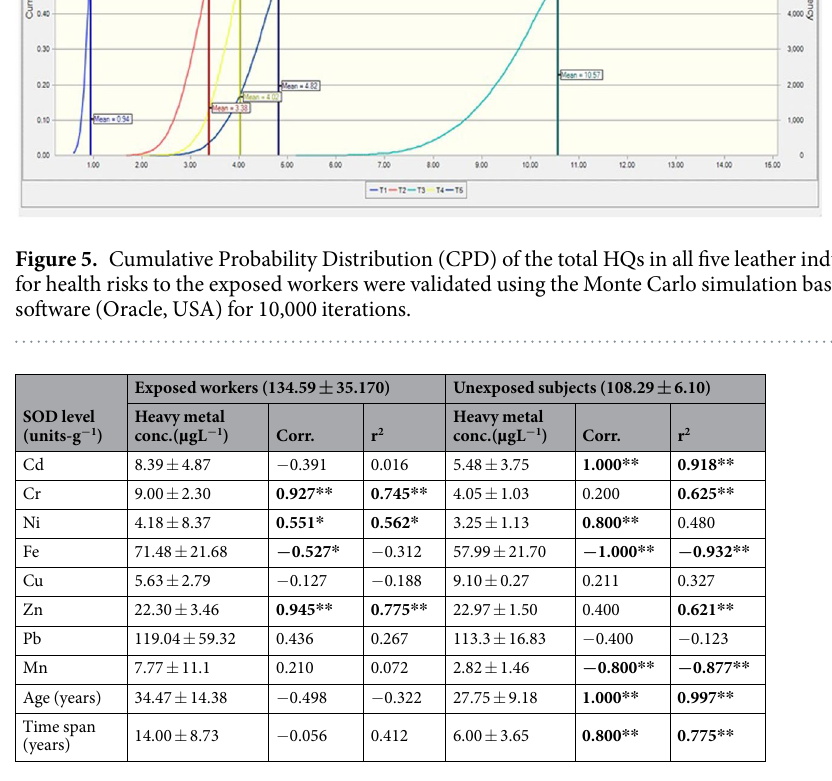
Table 1. SOD concentration (mean ± SD), correlation and regression analysis among the blood SOD levels, heavy metals, age and working exposure in the exposed groups and control. Corr. = Correlation matrix, r = linear regression * p ≤ 0.05, ** p ≤